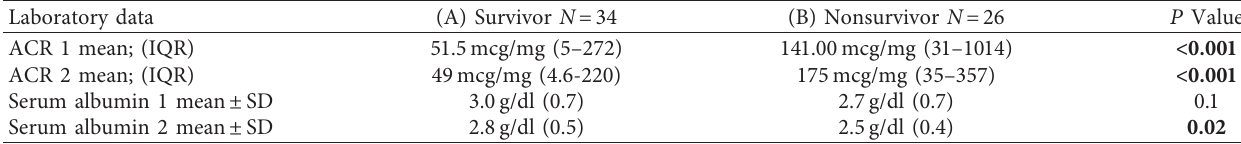
Table 2: Laboratory data in the two study groups.